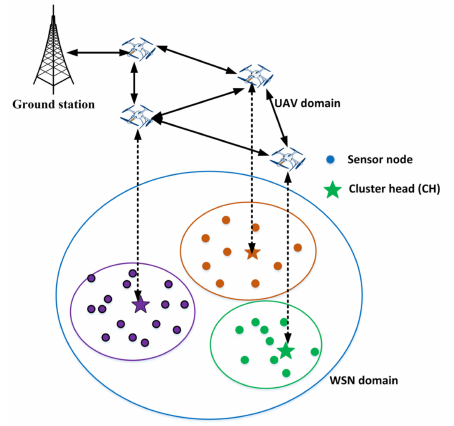
Figure 5. UAV and WSN